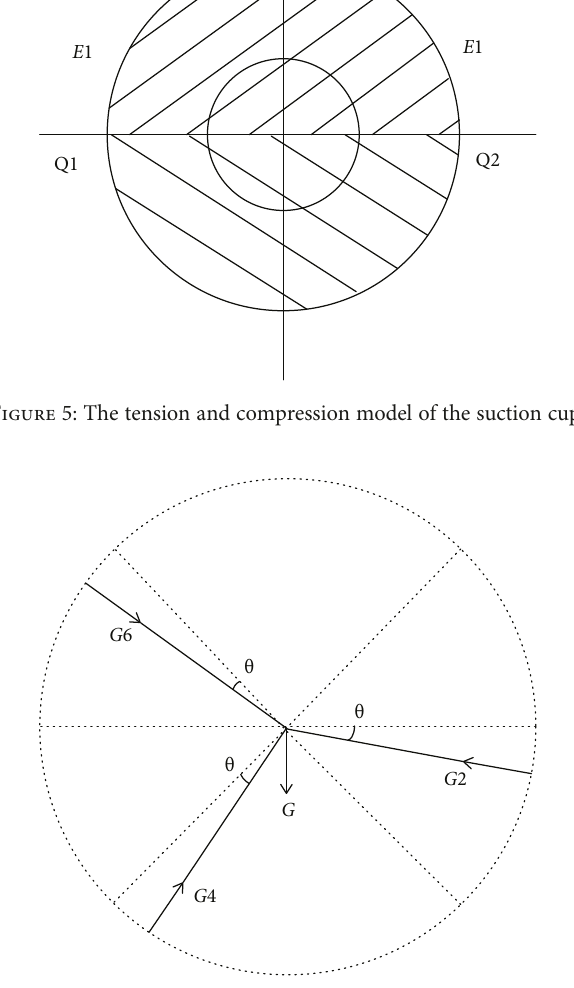
Figure 6: Force of state overturning